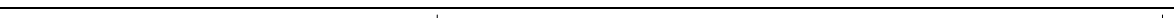
Fig. 4 CD24 − CD73 − γδ T17 cells do not develop in HEB ko FTOCs. a Representative FACS plots of CD24/CD73 γδ T cell subsets in WT and HEB ko FTOCs. b Quanti fi cation of the percentages of each CD24/CD73 developmental subset within all γδ T cells (CD3 + TCR γδ + ) in d7 and d10 FTOCs from WT and HEB ko mice. c Representative FACS plots of thymocytes WT and HEB ko FTOCs stained for intracellular ROR γ t and surface CD73 gated on the CD24 − population. d Quanti fi cation of the frequencies of ROR γ t + cells within the CD24/CD73 subsets in WT and HEB ko FTOCs. e Representative FACS plots depicting intracellular IL-17A expression vs. CD73 expression in CD24 − γδ T cells from WT and HEB ko FTOCs after 5 h of stimulation with PMA/Ionomycin (PMA/ Iono) and treatment with Brefeldin A. f Frequency of IL-17A + cells within CD24 − CD73 + or CD24 − CD73 − γδ T cells in FTOCs from WT and HEB ko mice treated with Brefeldin A alone (None) or PMA/Iono and Brefeldin A (P/I) for 5 h. All plots are gated on CD3 + TCR γδ + cells. Numbers in FACS plots indicate frequency within each gate. Data are representative of at least three independent experiments with at least 3 mice per group. Center values indicate mean, error bars denote s.e.m. p -values were determined by two tailed Student's t -test. ND = not done due to low cell number. NS = not signi fi